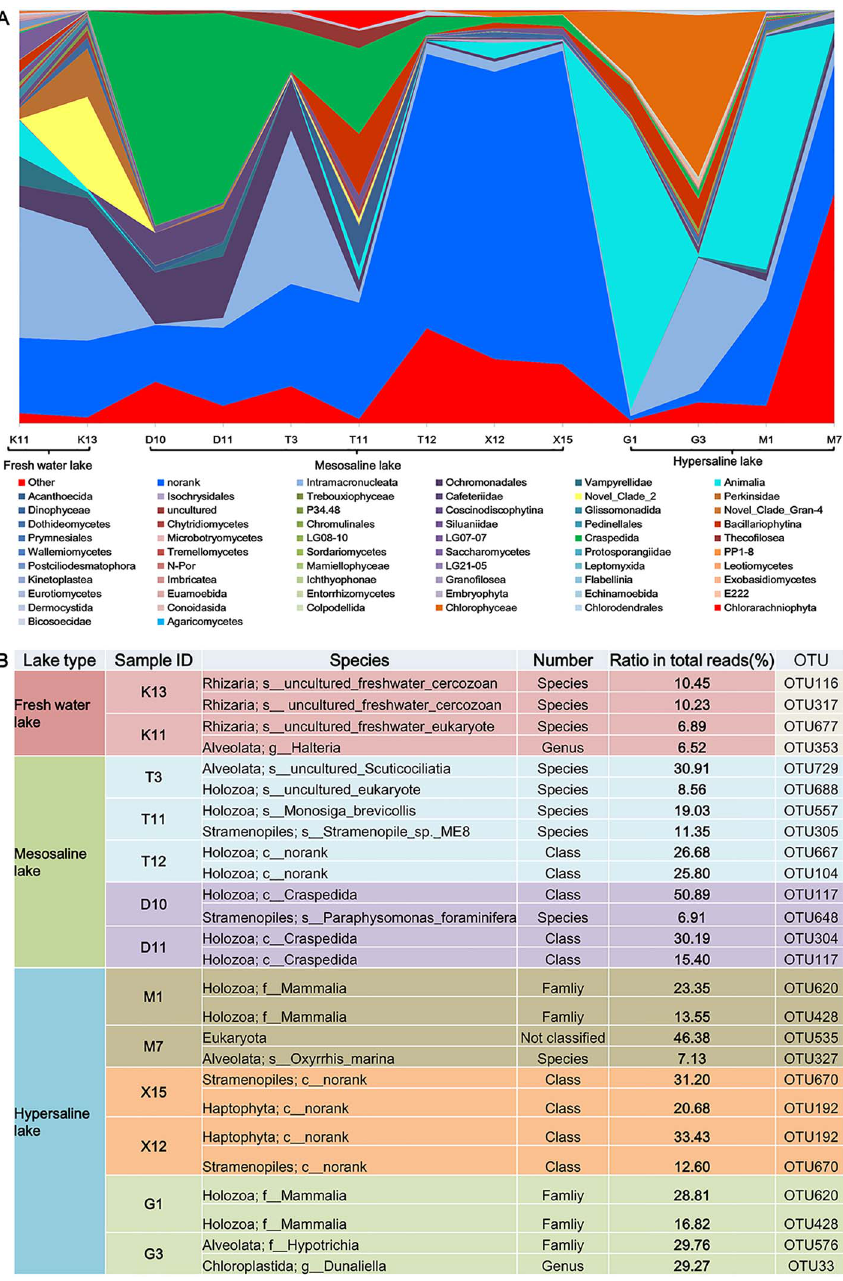
Figure 5. Taxa assignments at Class rank or below of investigated sample sits and the most abundant taxa in each habitat. (A) Taxa assignments at Class rank or below of investigated sample sits. (B) Taxa assignments at Class rank or below in each habitat. The class ‘‘other’’ means group that could not be precisely assigned to any known eukaryotic taxonomic group. The class ‘‘norank’’ means group that could not be precisely assigned to eukaryotic taxonomic group at least at the class level within kingdom. ‘‘Incertae sedis’’ is a term used for a taxonomic group where its broader relationships are unknown or undefined.